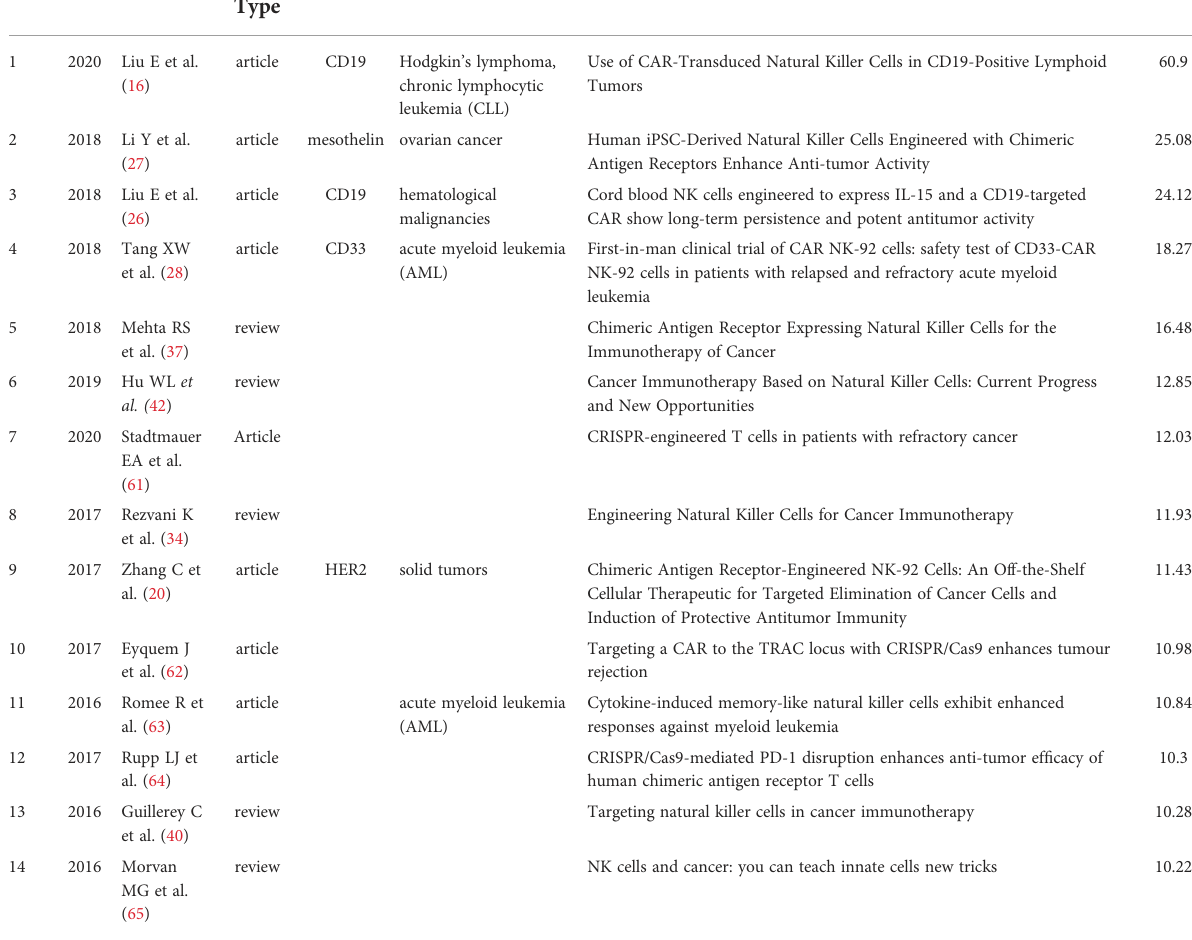
TABLE 6 The references (in the state of citation burstness) related to CAR-NK cells or NK cells.